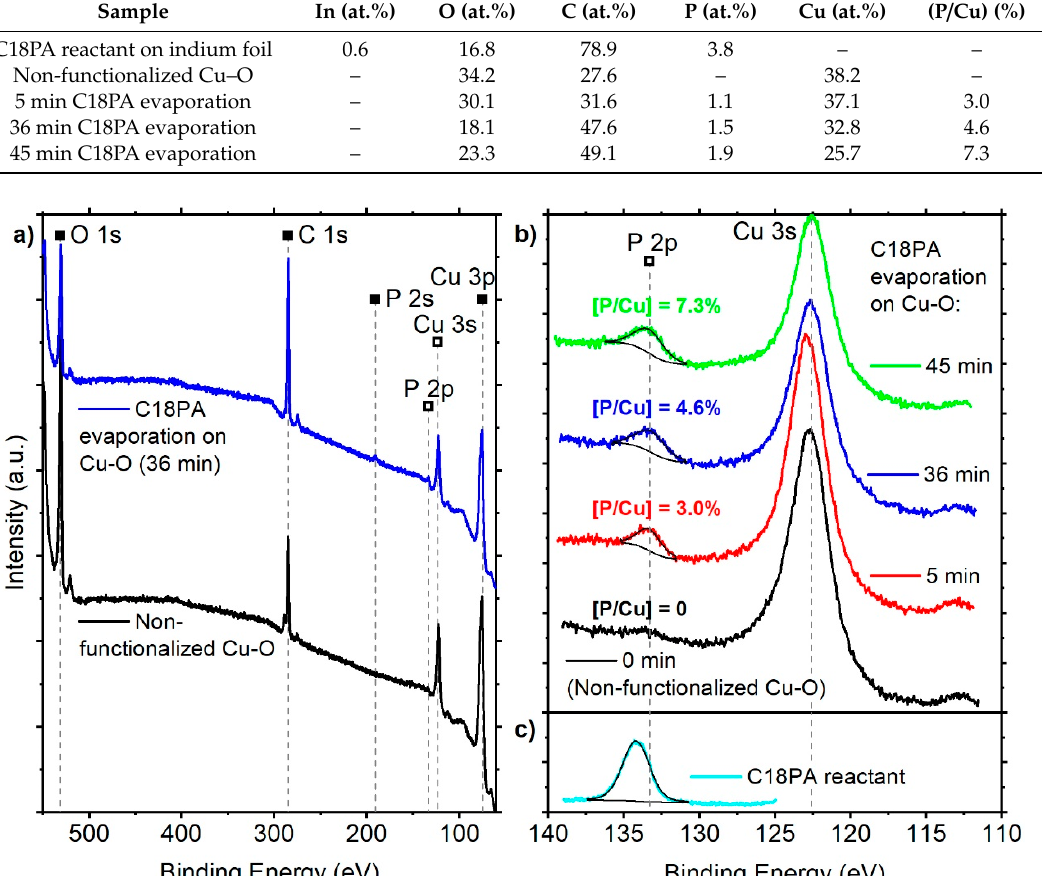
Figure 2. Survey ( a ) and detailed ( b ) photoelectron spectra of functionalized (colored lines) and non-functionalized (black line) Cu–O surfaces as well as of C18PA reactant ( c ) measured on indium foil. Signals labeled with filled symbols in ( a ) were used for the determination of chemical compositions in Table 1, inscriptions above P 2p signals in ( b ) refer to the P/Cu-ratio from Table 1. Table 1. Chemical composition of C18PA reactant as well as of functionalized and non-functionalized surfaces obtained by photoelectron signals of elements labeled with filled symbols in Figure 2a.